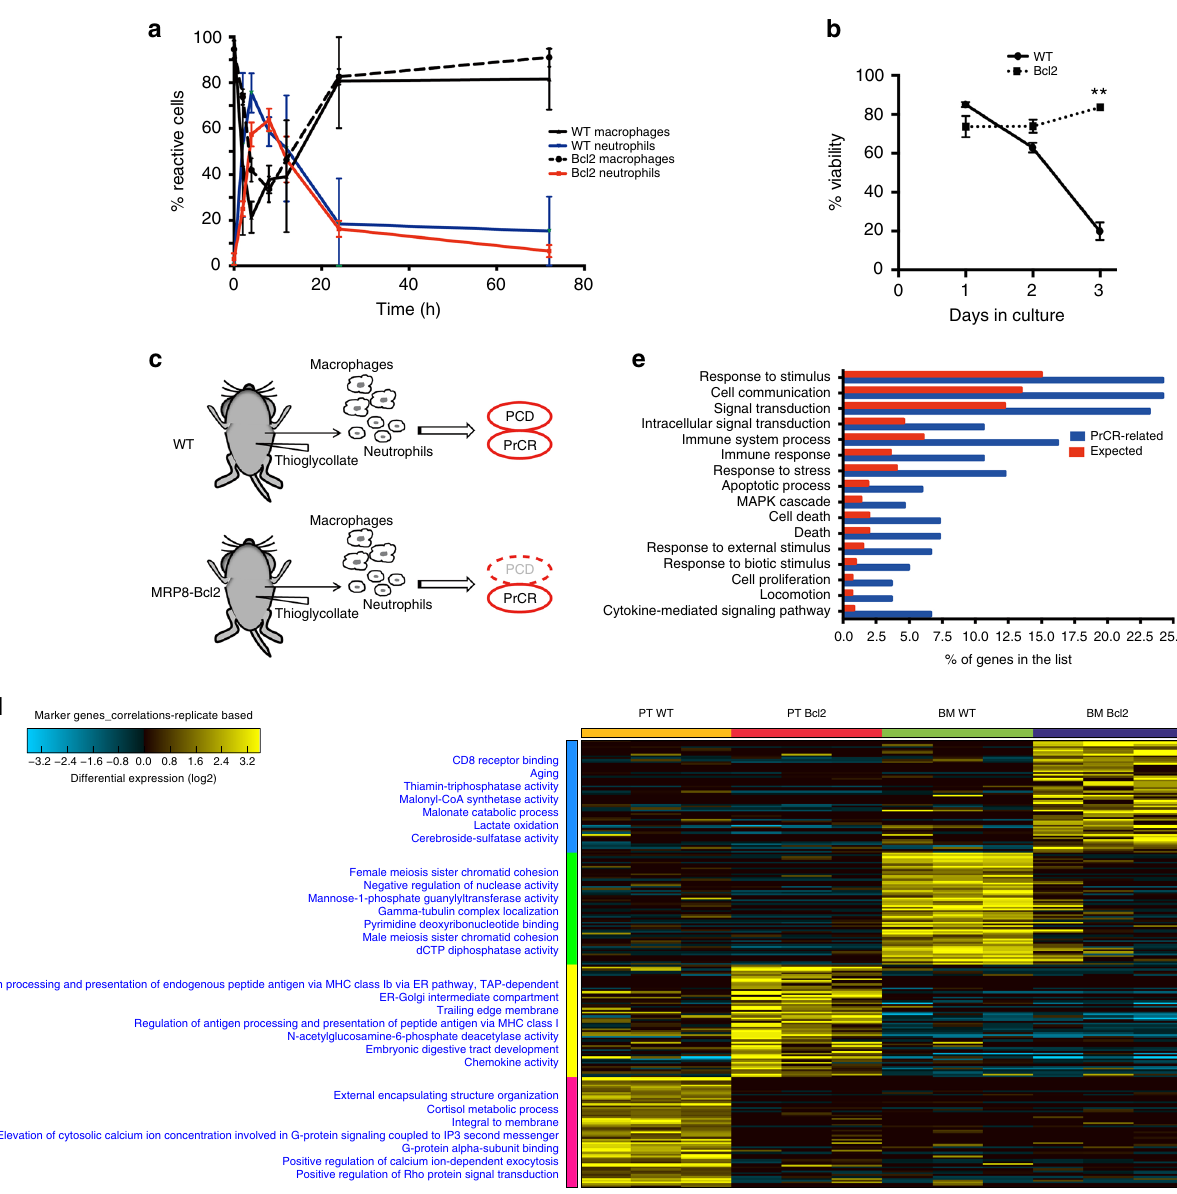
Fig. 1 Viable aged neutrophils are cleared through activation of program cell removal. a Analysis of neutrophil and macrophage cell populations after thioglycollate injection to WT and MRP8-Bcl2 mice. Peritoneal cells were collected and analyzed at 0, 2, 4, 8, 12, 24, and 72 h after thioglycollate injection. Similar lifespan was observed for WT and Bcl2 macrophages and neutrophils. Macs, macrophage;s WT, wild-type; PMN, neutrophil/polymorphonuclear cell. Results are representatives of three independent experiments. n = 3 mice for each time point. Error bars represent standard deviation. Cells were identi fi ed by surface markers such as CD11b + F4/80 - GR1 ++ (Neutrophils), CD11b + F4/80 + (macrophages). Percentage reactive cells, the % of the total viable cells found in the peritoneum after induction of peritonitis. b WT but not Bcl2 neutrophils undergo cell death. WT and Bcl2 neutrophils were collected and cultured in vitro for 72 h. Cell viability was examined by AnnexinV and DAPI staining. Cells that were AnnexinV-DAPI- were considered as viable cells. n = 3. ** P < 0.01 ( t -test) for viability between WT and Bcl2 neutrophils. Error bars represent standard deviation. c A schematic showing peritonitis in WT and MRP8-Bcl2 mice. WT neutrophils undergo both programmed cell death (PCD) and programmed cell removal (PrCR) after maturation while Bcl2 neutrophils are resistant to PCD but maintain PrCR programs. d RNAseq anaylsis of 4 groups of neutrophils, including (1) WT neutrophils from bone marrow (BM), (2) WT neutrophils recruited to peritoneum (PT), (3) MRP8-Bcl2 neutrophils from bone marrow, and (4) MRP8-Bcl2 neutrophils recruited to peritoneum. PT, peritoneal; BM, bone marrow. e Distribution among different cellular pathways ( y -axis) of: (blue) 333 genes that are associated with increased susceptibility to PrCR and (red) genes in the human genome. RNAseq analysis was performed on 4 groups of neutrophils, as described in d . RNAseq analysis was used to identify genes upregulated in the maturation process (BM to peritoneum) in both WT and MRP8-Bcl2 mice, which are likely associated with susceptibility to